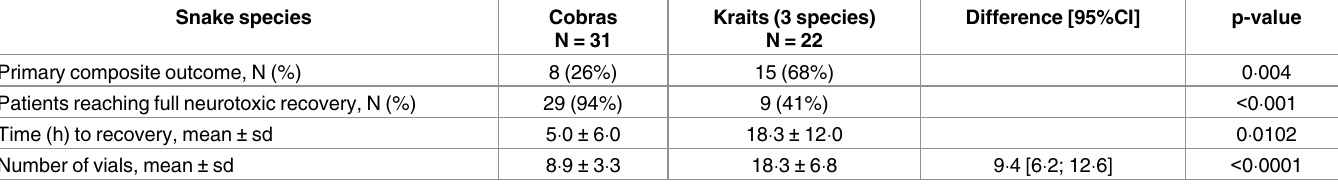
Table 3. Effectiveness endpoints by biting species. Snake